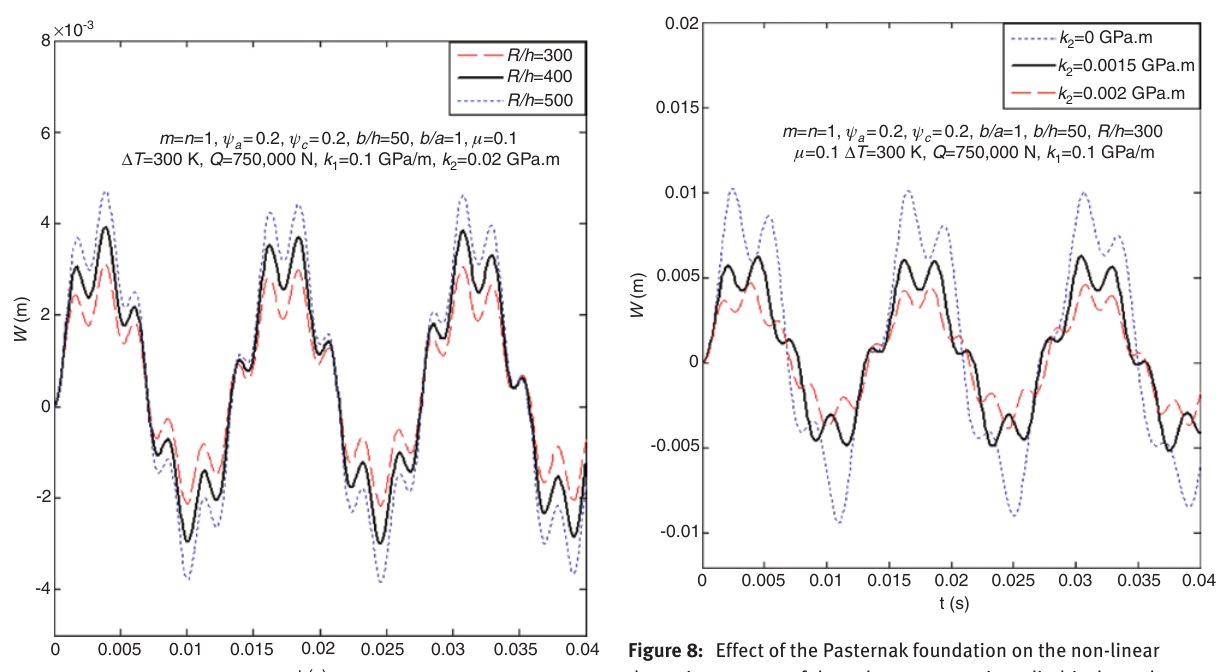
Figure 8: Effect of the Pasternak foundation on the non-linear dynamic response of the polymer composite cylindrical panel.